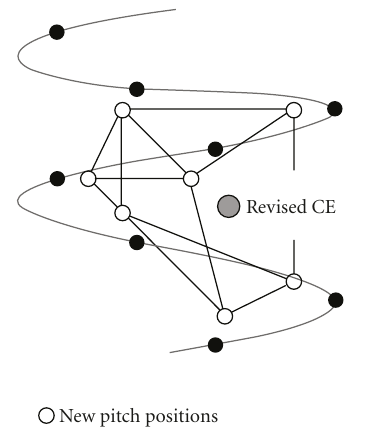
Figure 7: Recalculating pitch position using pitch-class distribu- tion.